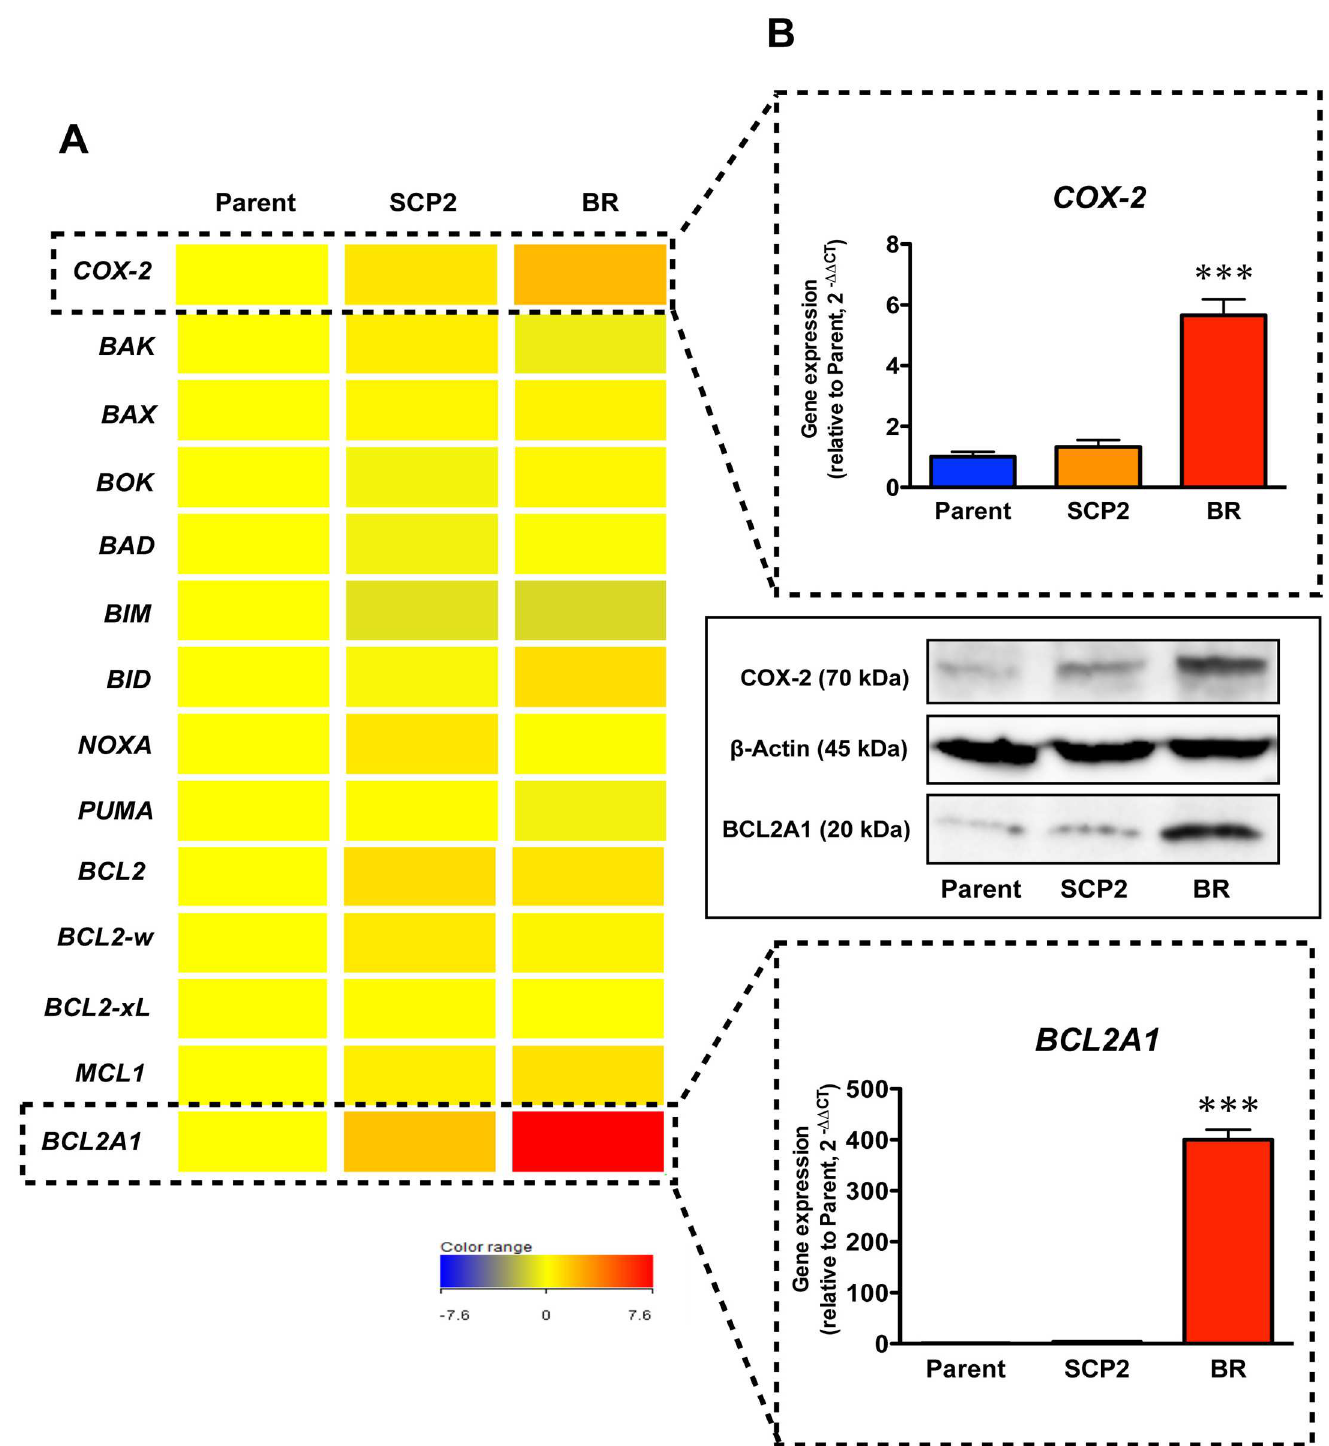
Fig 3. Elevated gene and protein expressions of COX-2 and BCL2A1 in MDA-MB-231BR. (A) Gene expressionlevels in MDA-MB-231 (Parent), MDA-MB-231SCP2 (SCP2), and MDA-MB-231BR (BR). Candidategenes for drug resistance were screened by RNA sequencing. The intensity of gene expressionin the heat map is shown relative to that in the Parent. (B) COX-2 and BCL2A1 mRNA and protein expression levels in Parent, SCP2, and BR. mRNA expression levels in the SCP2 and BR are shown relative to those in the Parent. Data represent the mean with SEM of at least three independent samples ( *** P < 0.001 vs . Parent and SCP2) for mRNA expressions.